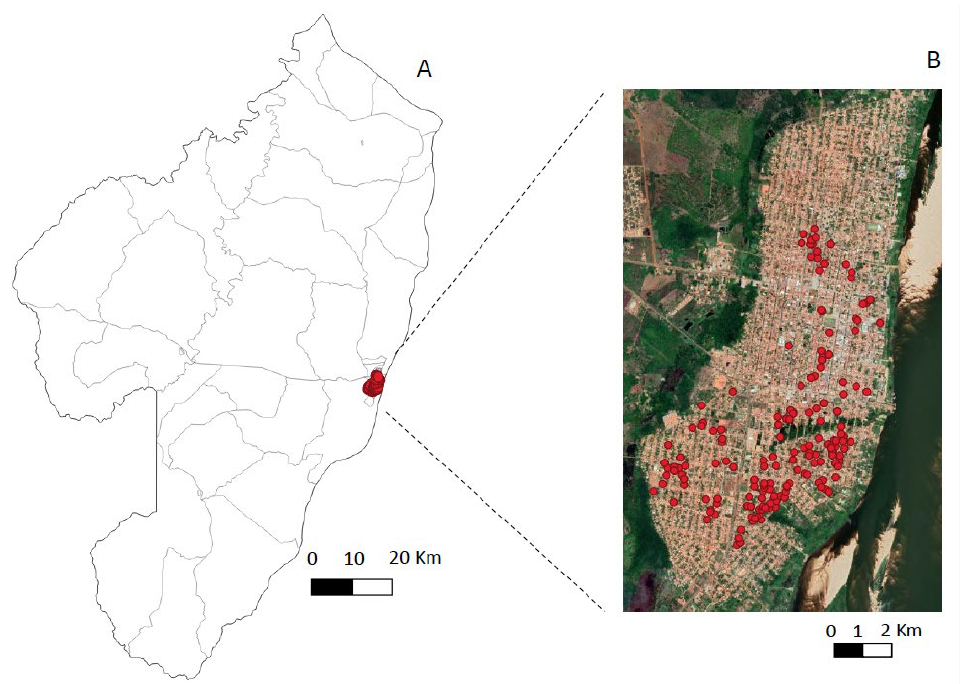
Figure 3. Spatial distribution of positive samples [human L. ( L. ) infantum chagasi -infections] in Conceiç ã o do Araguaia (Par á State, Brazil) (2016–2017). Spatial resolution of the municipality ( A ) and urban area ( B ).